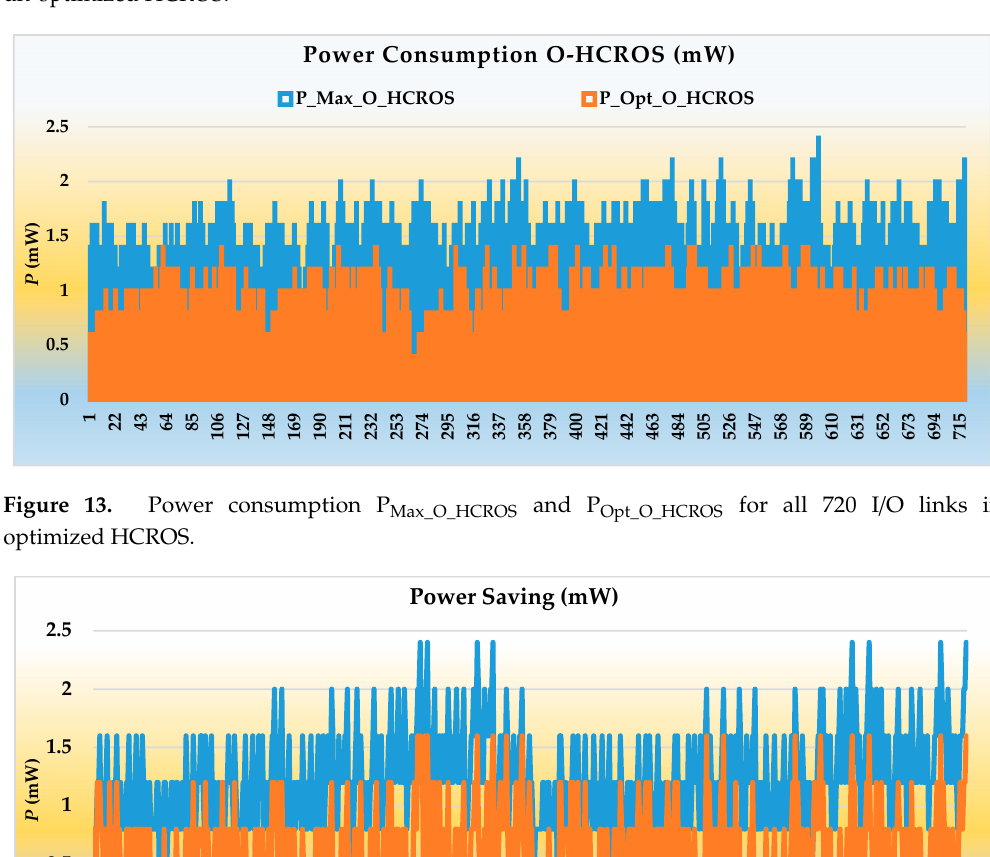
Figure 12. Power consumption P Max_UO_HCROS and P Opt_UO_HCROS for all 720 I/O links in un-optimized Figure 12. HCROS .